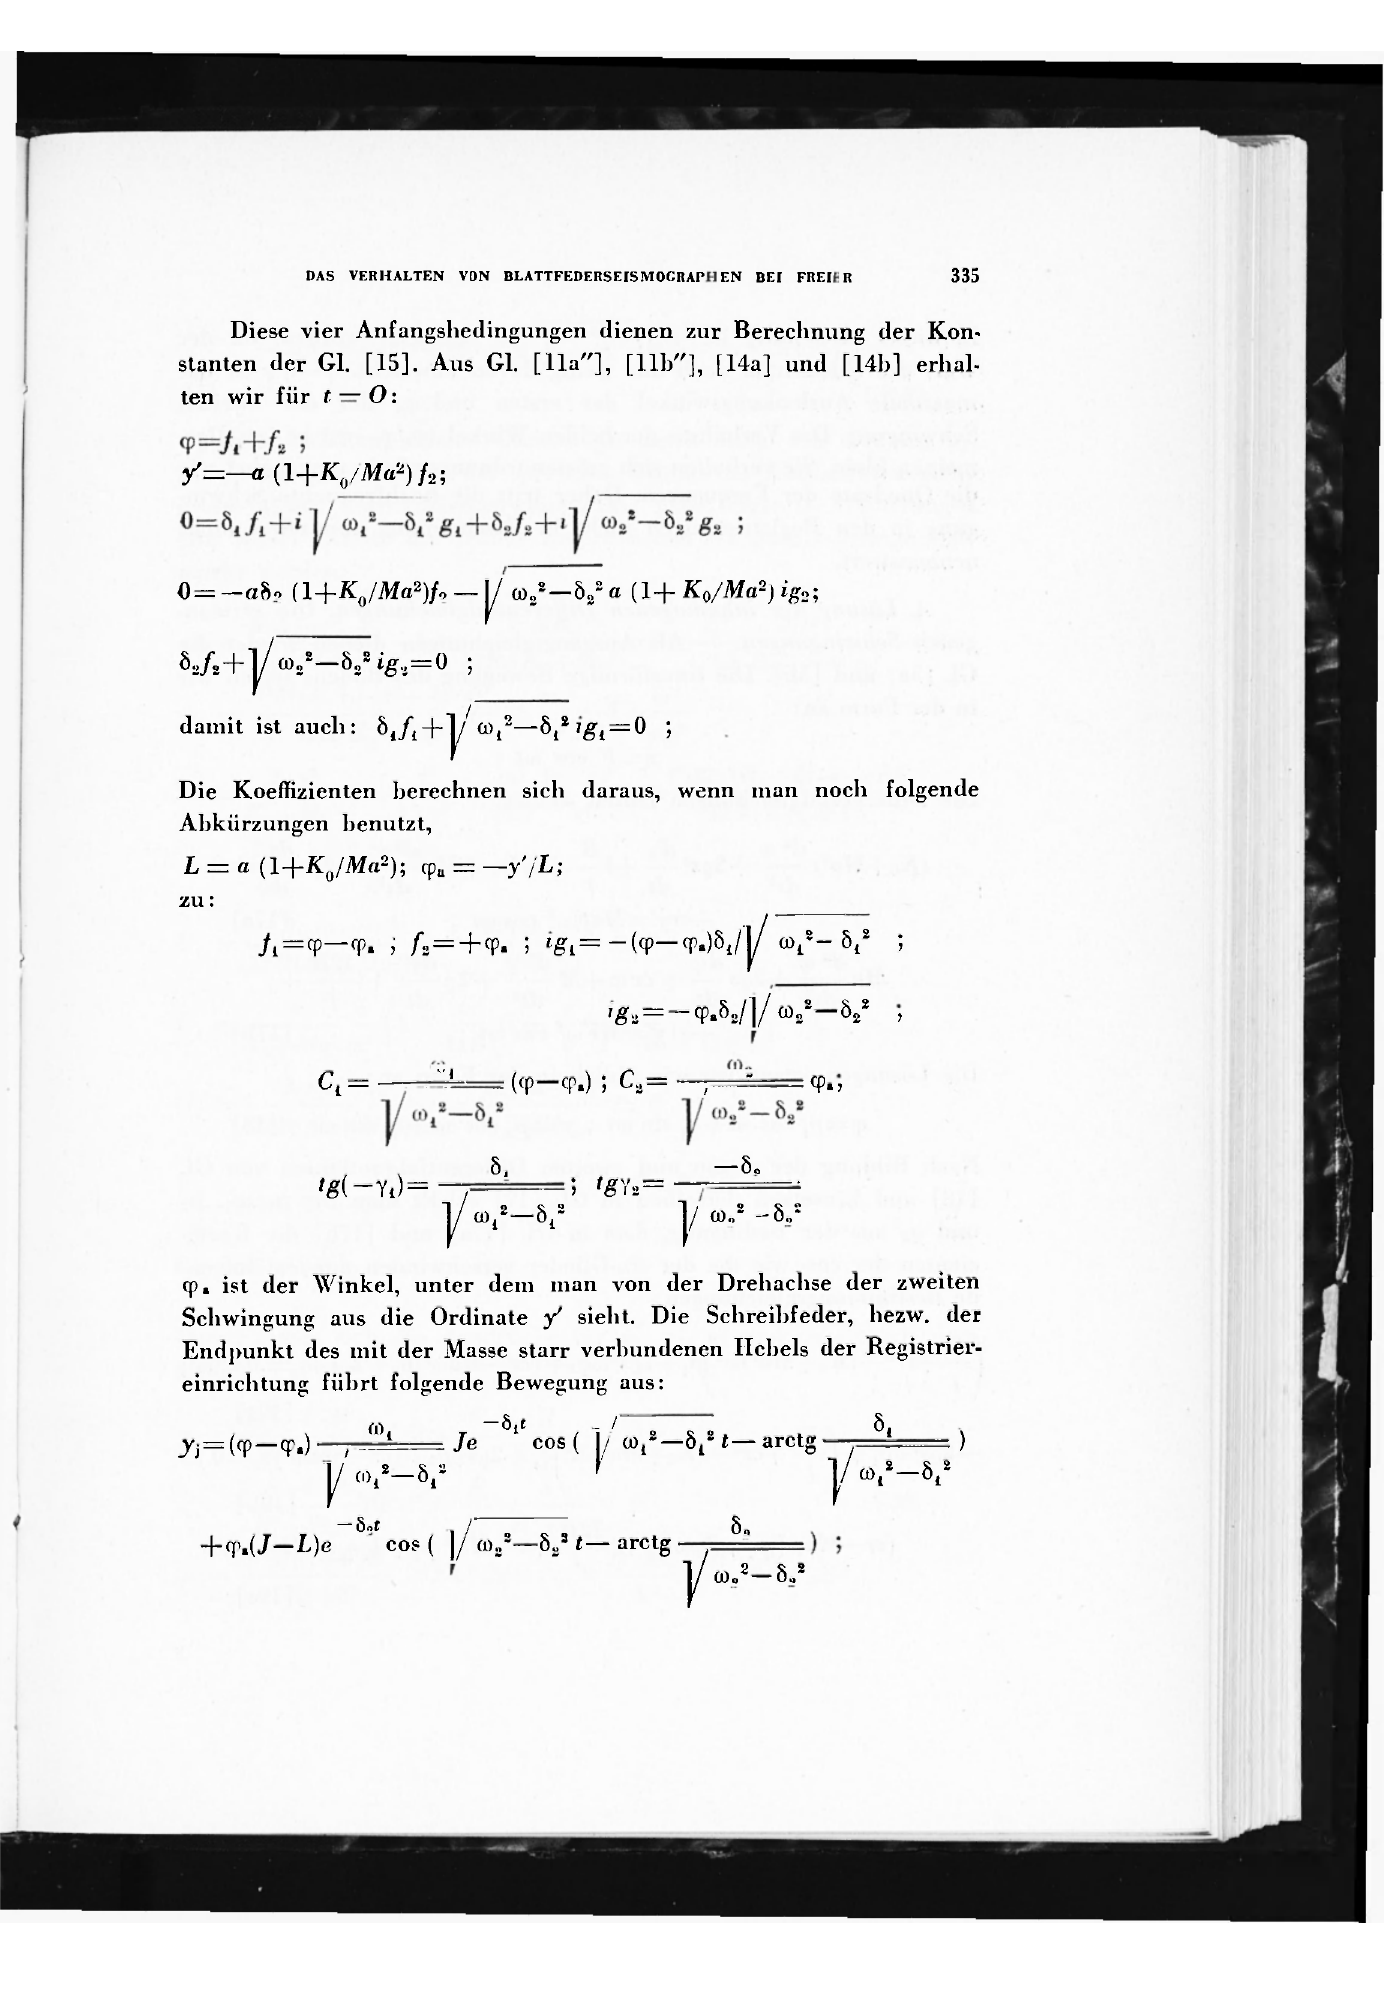
DAS VERHALTEN VON BL ATTFEDERSEISMOGRAPIIEN BEI FREIF.R 335